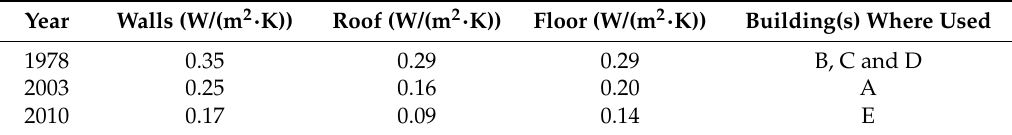
Table 3. The overall heat loss coefficient values for the walls, roof and floor of the building in different years based on the National Building Code of Finland [55].